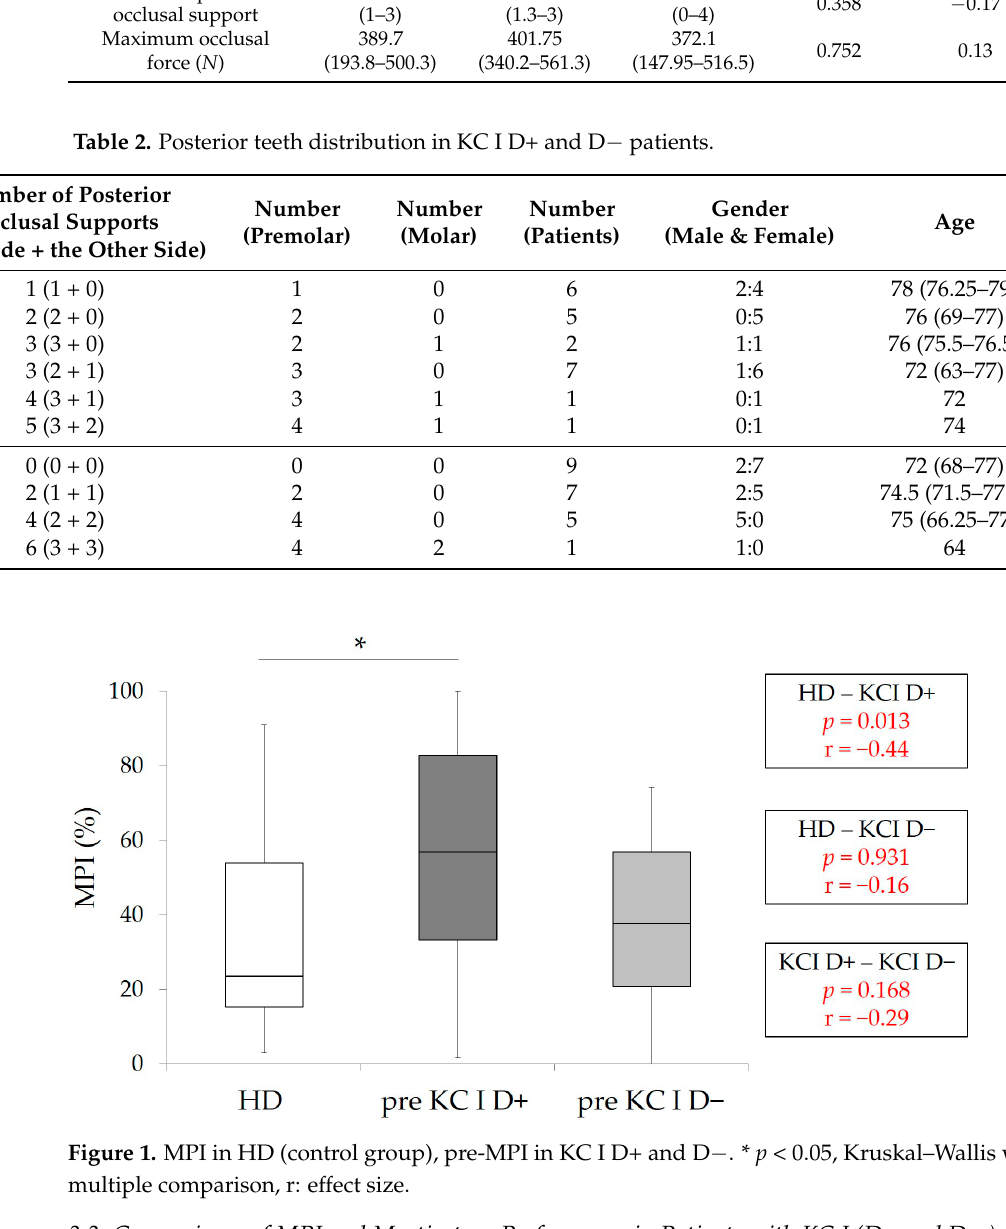
Figure 2. Masticatory function in HD (control group), pre-masticatory function in KC I D+ and D − . * p < 0.001, Kruskal Wallis with multiple comparison, r: effect size. 3.3. Comparisons of MPI and Masticatory Performance in Patients with KC I (D+ and D − ) Between Pre- and Post-RPD Treatment To evaluate the influence of RPD treatment on mastication predominance and mas- ticatory performance, pre- and post-measurement values were statistically compared. The results of statistical comparison between pre- and post-MPI in each group (KC I D+ and KC I D − ) are shown in Figure 3. A wide range of MPI values was also observed in all groups. In KC I D+ and KC I D − , RPD treatment could decrease MPI significantly ( p < 0.05, Wilcoxon signed-rank test). Furthermore, Figure 4 clearly indicates that RPD treatment